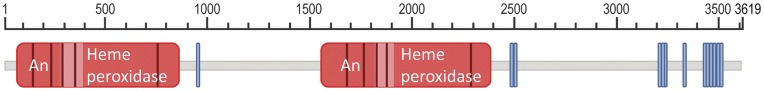
Domain architecture of PepA.Two animal peroxidase-like domains (according to PROSITE profile PS50292) are shown in red, with an internal region of low homology marked in fair red; sequences with the consensus G-X-D-G-X(5)-D-D interrupting the domains are shown in brown bars and hemolysin calcium binding motifs (according to PS0033) are in blue bars. Numbers indicate amino acid residues.